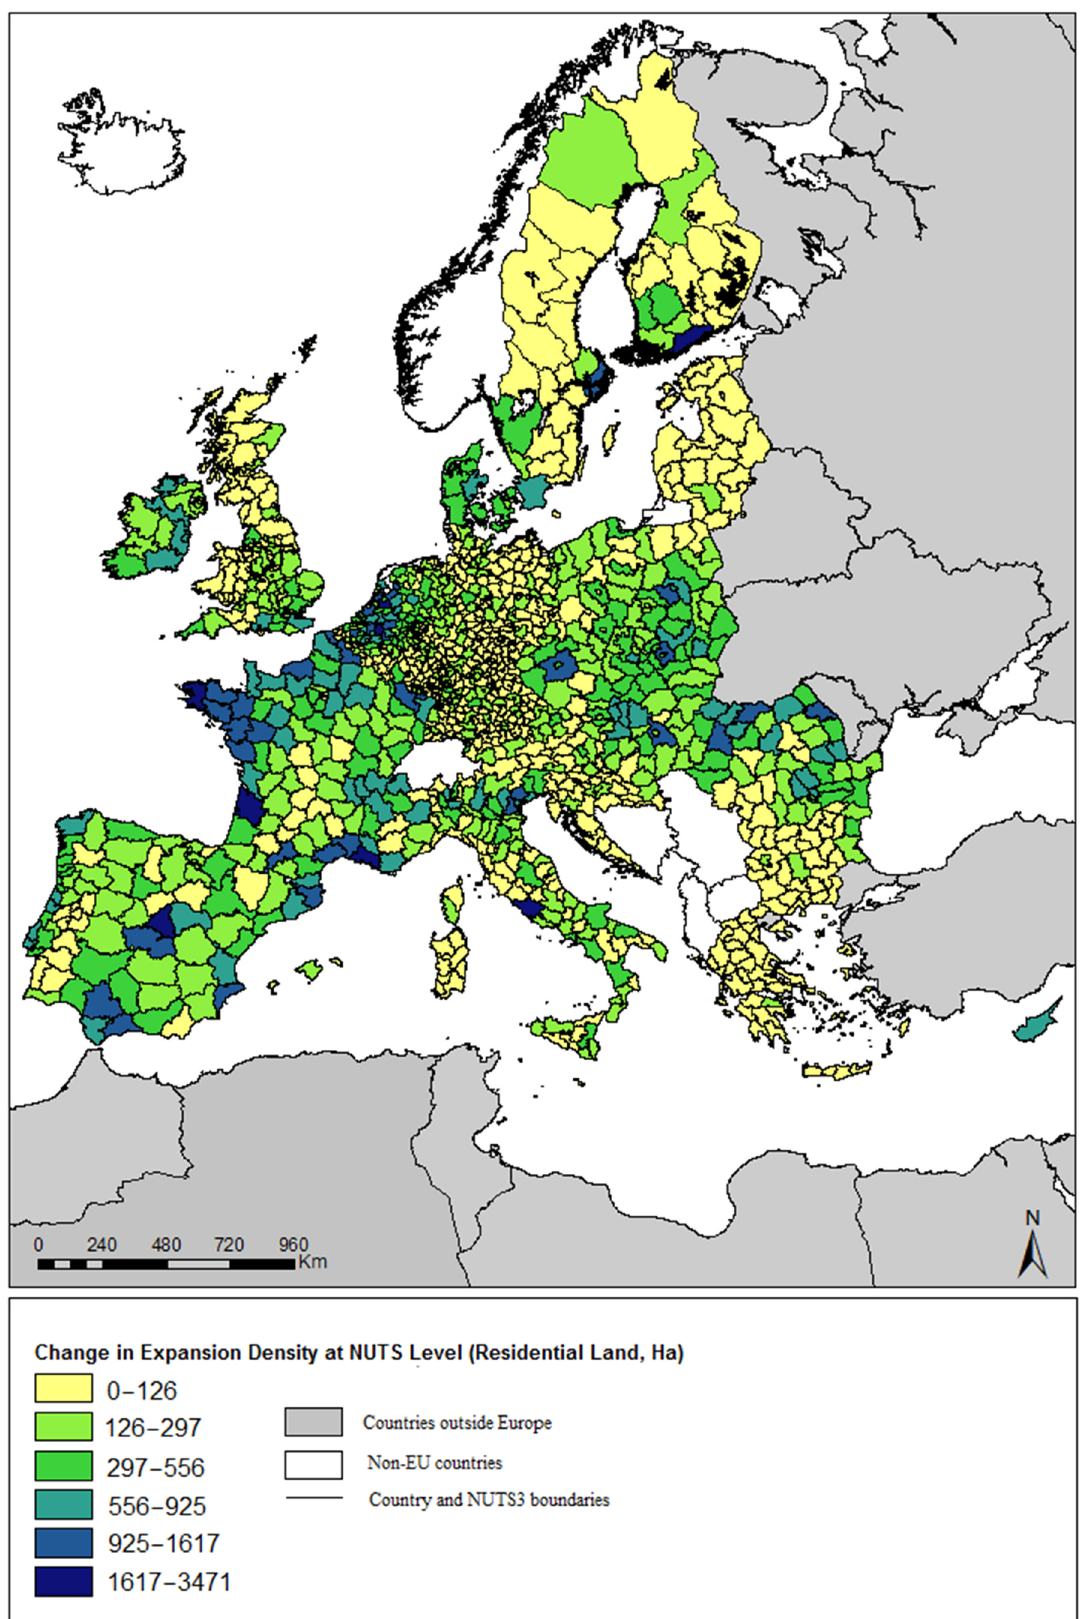
Figure A1. Change in density in residential expansion areas (NUTS3 level) between 2000 and